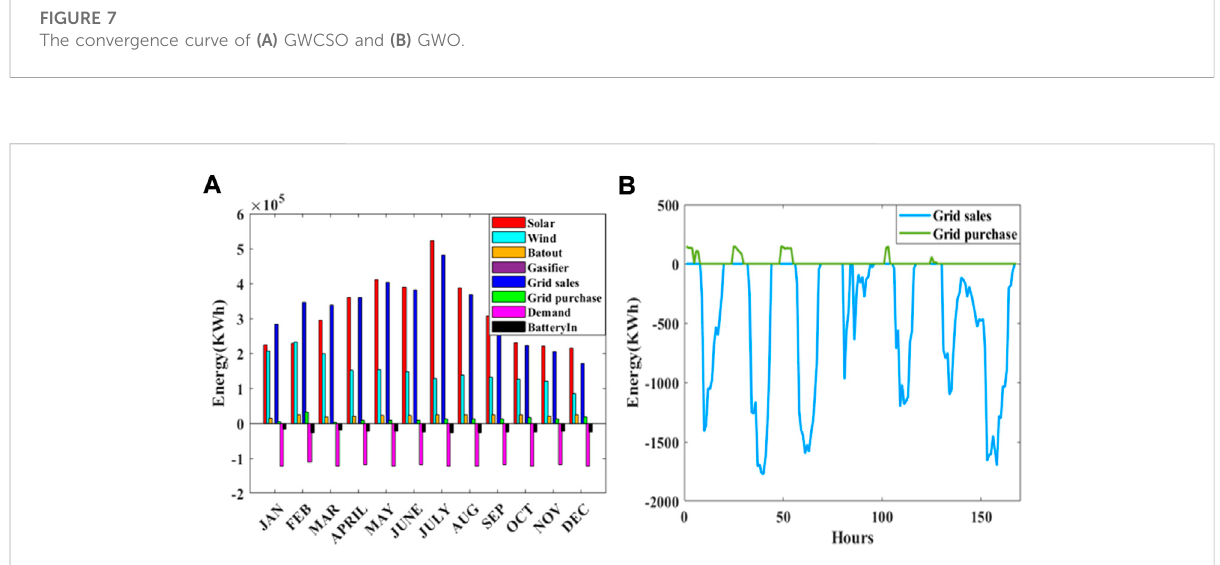
FIGURE 8 (A) Monthly and (B) Daily average energy balance over a